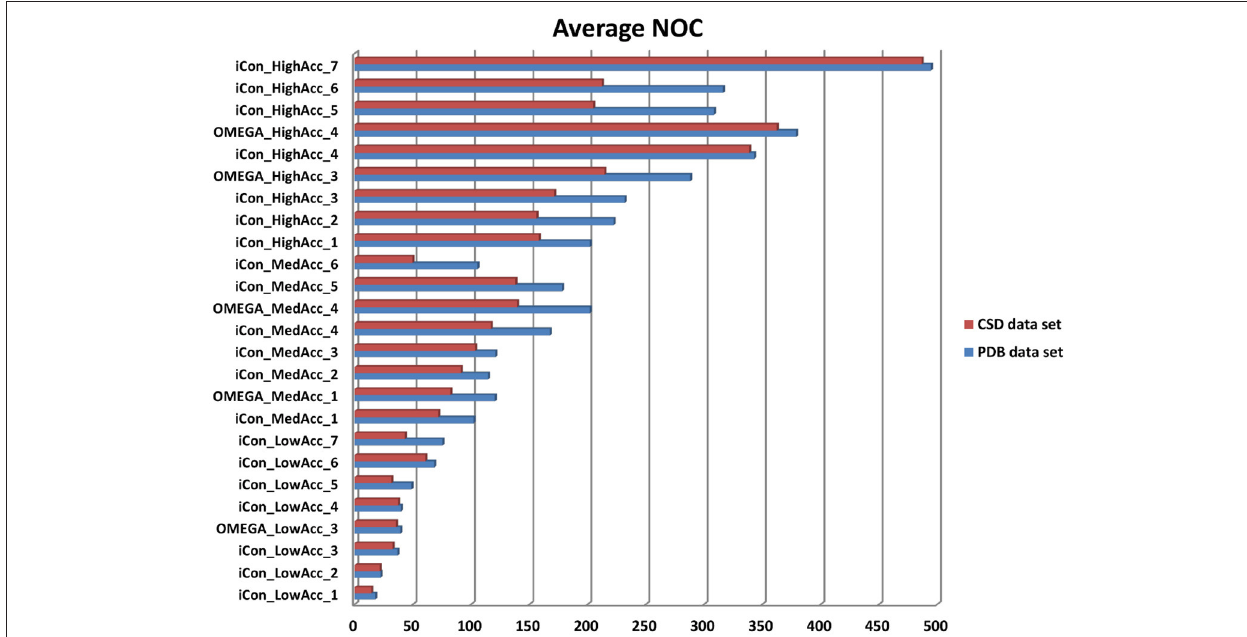
FIGURE 3 | Number of conformers (NOC) generated by iCon and OMEGA for PDB data set (blue bars) and CSD data set compounds (red bars) with different settings. For iCon all the tested settings are reported; for OMEGA only some representative settings are shown as a